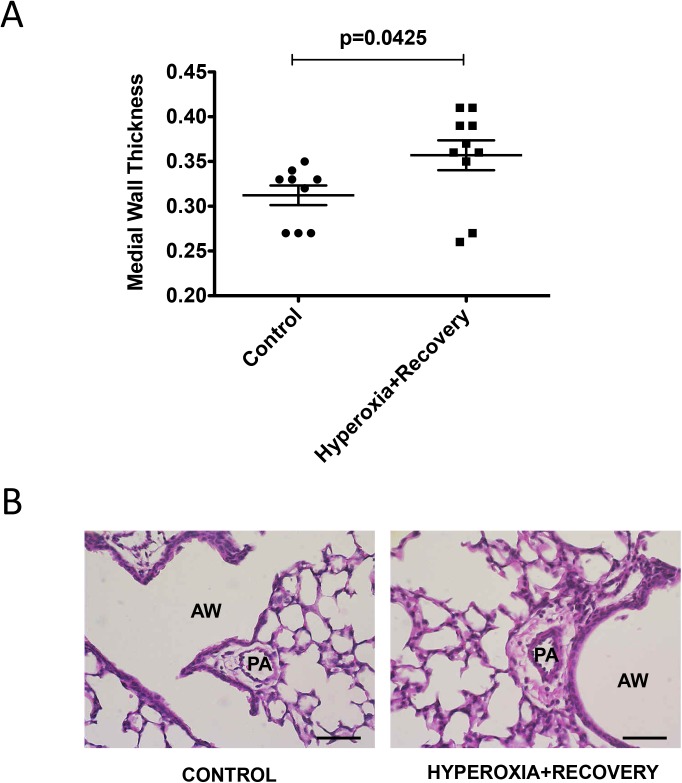
Mice exposed to hyperoxia during the neonatal period have persistently elevated medial wall thickness at 21d.Mice were exposed to hyperoxia or room air for 14d, followed by recovery in room air for an additional 7d (21d). (A) MWT was measured as the ratio of the small PA wall area over total PA area (n = 9–10 animals per group). (B) Representative H&E-stained lung sections are shown for control 21d and hyperoxia + recovery 21d. Bar = 50 μm. Data are expressed as dot plots with each dot representing individual animals with means and SEM represented by horizontal lines. Results were analyzed using an unpaired t-test. PA = Pulmonary Artery, AW = Airway.